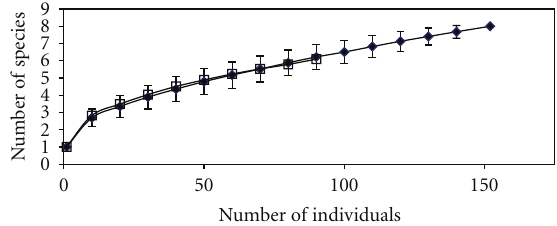
Figure 2: Rarefaction analysis. Expected species richness for given numbers of individuals collected in each habitat type, generated using EcoSim software [28]. Filled diamonds represent edge habitat, while open squares are for interior habitat. The 95% confidence intervals shown were generated using the edge site